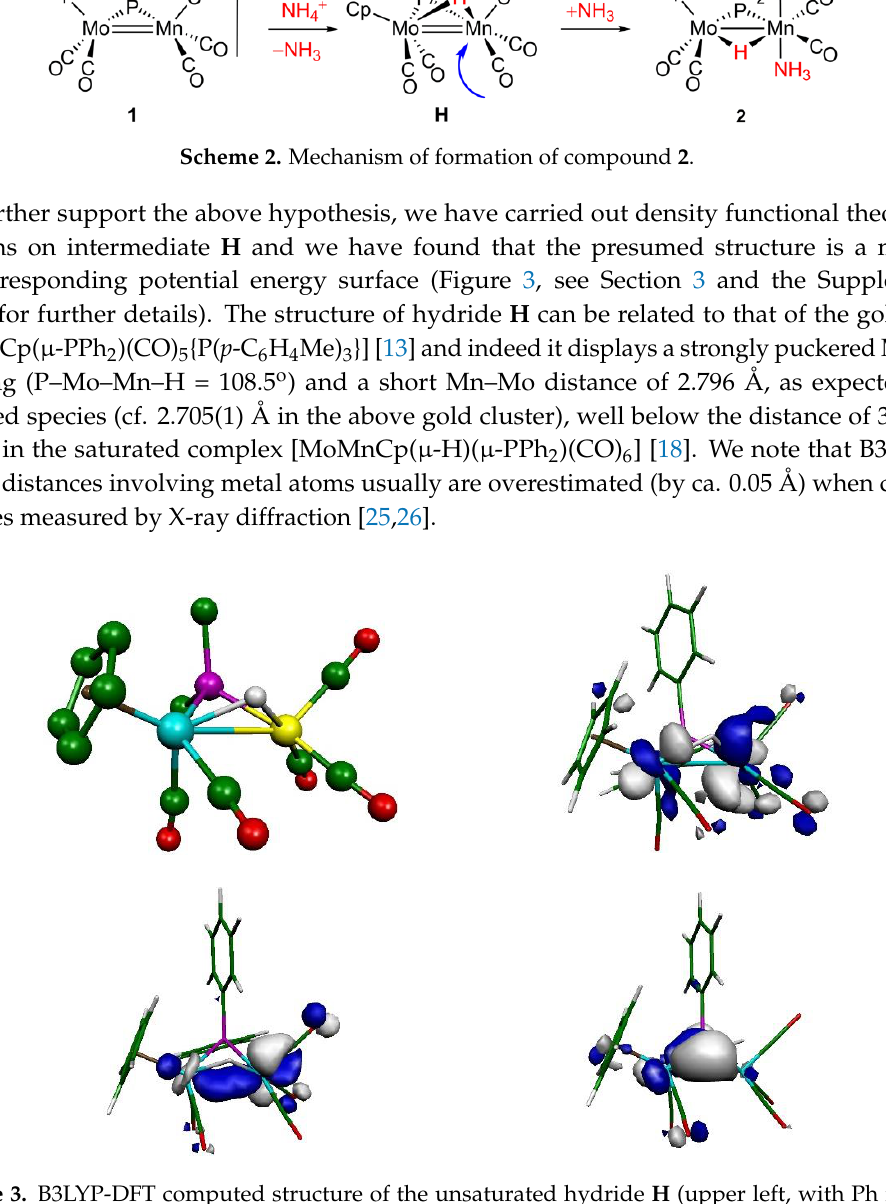
Figure 3. B3LYP-DFT computed structure of the unsaturated hydride H (upper left, with Ph rings and most H atoms omitted) along with the corresponding LUMO (upper right, − 2.25 eV), HOMO − 5 (lower left, − 6.82 eV) and HOMO − 12 orbitals ( − 8.74 eV).